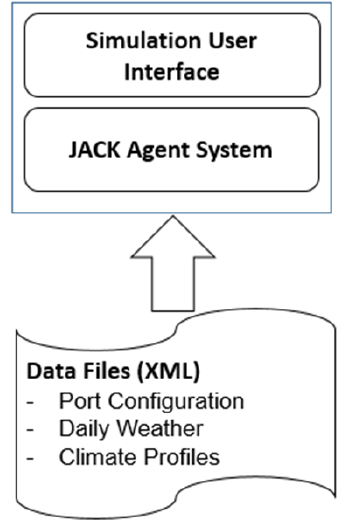
Figure 2. Simulation system